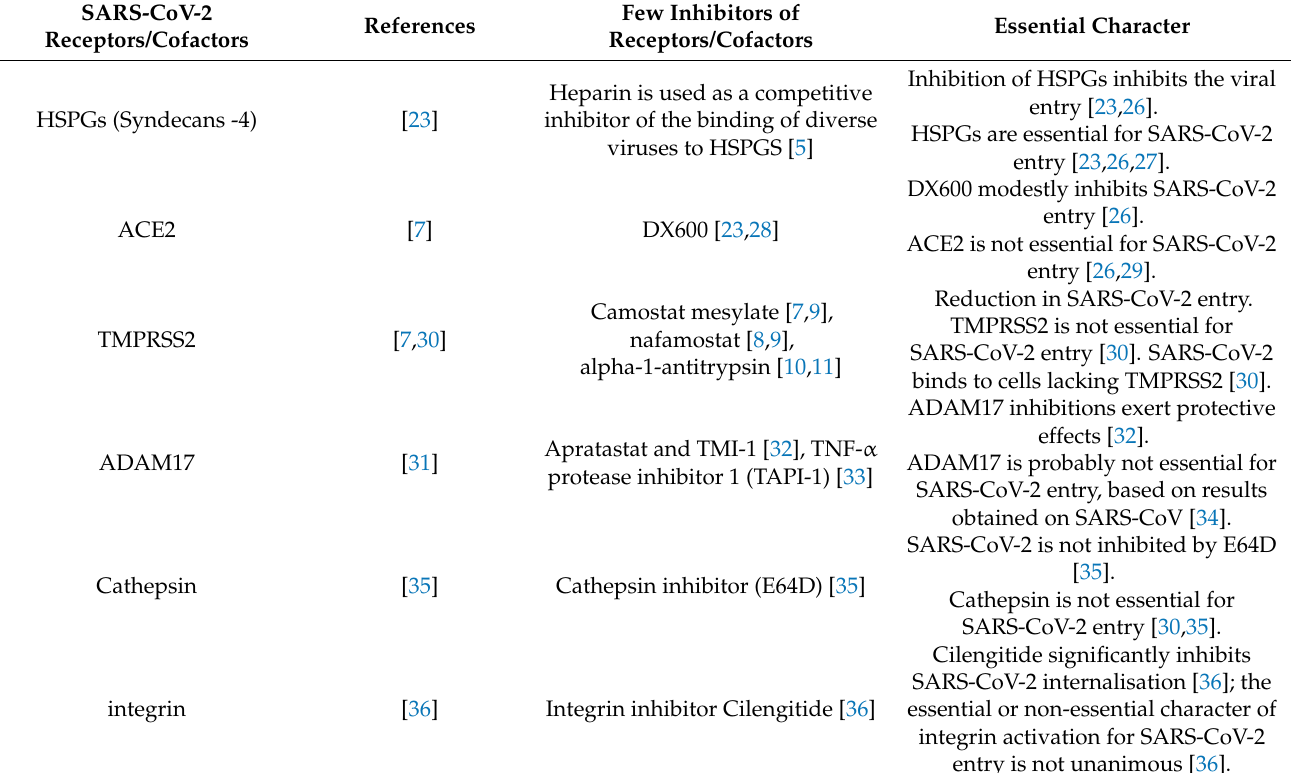
Table 2. SARS-CoV-2 entry: essential and non-essential characteristics of some